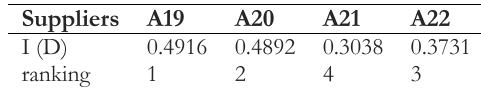
Table 5. Ranking of suppliers of parts category